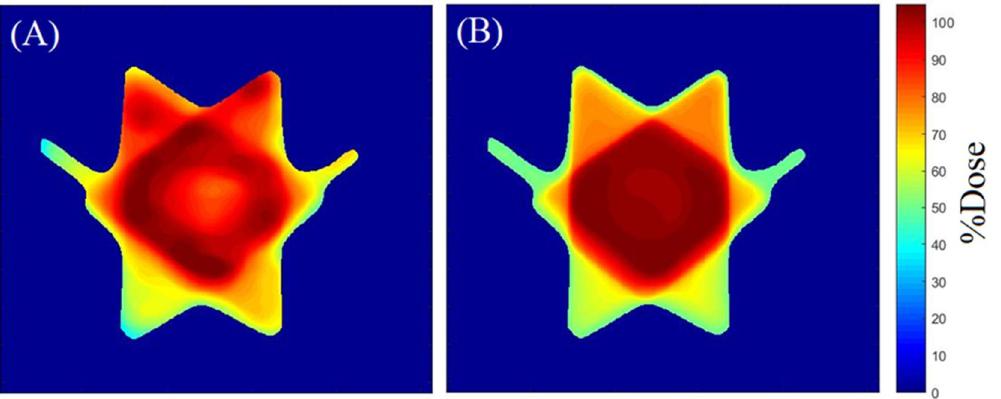
Figure 4. Dose distribution measured by the gel dosimeter with OCT scanning ( A ), and the corresponding slice (5.4 cm) calculated by the TPS ( B )—40% of threshold.